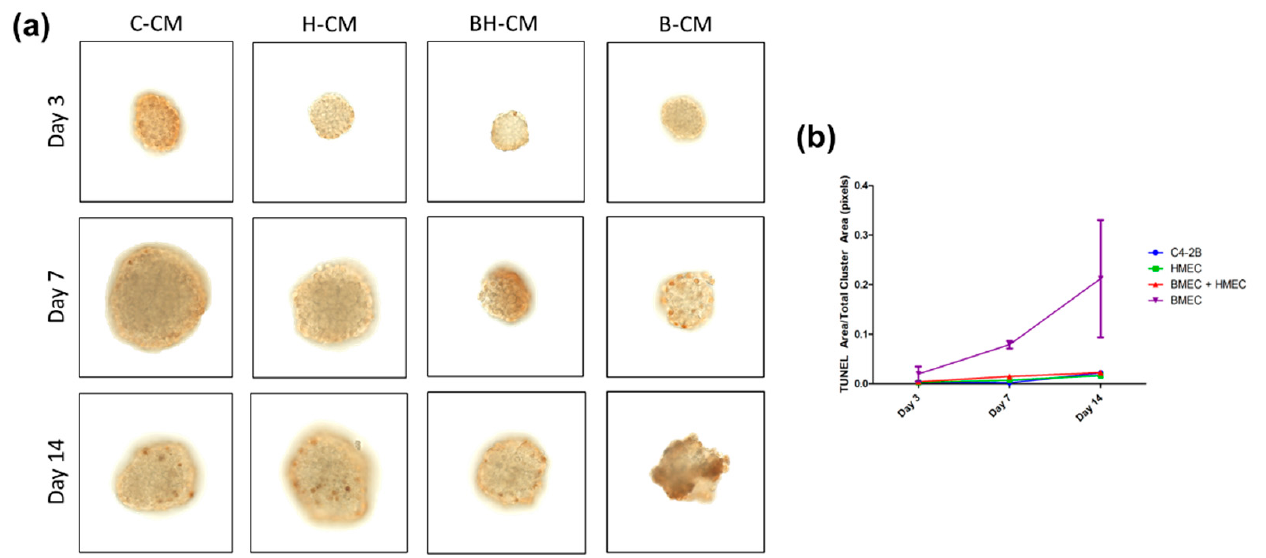
Figure 5. TUNEL assay of conditioned medium (CM)-treated C4-2B clusters. Colorimetric TUNEL assay of C4-2B clusters cultured in microwells and treated with cancer cell CM (C-CM), HS27A-only CM (H-CM), BMEC and HS27A CM (BH-CM), and BMEC only CM (B-CM) on days 3, 7, and 14. Dark brown spots indicate cells that are undergoing apoptosis ( a ). Size in the pixel area of stain (dark brown) over total cluster area for each treatment group ( b ).